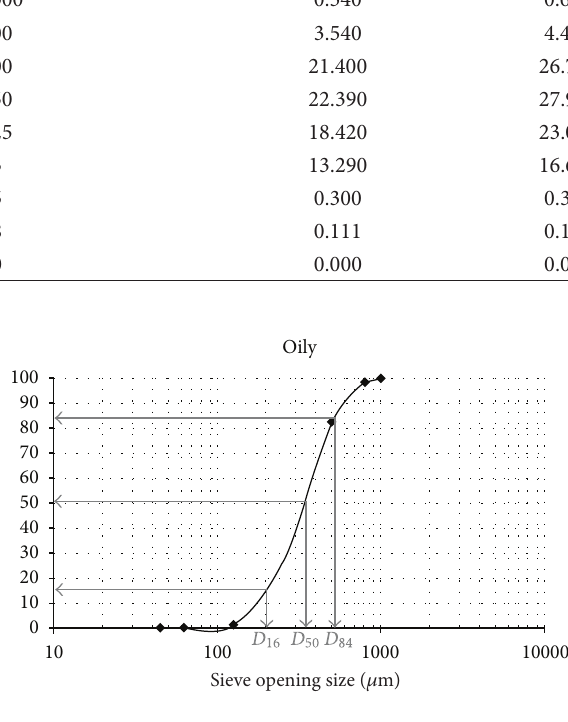
F 1: Lognormal distribution plot of cumulative undersize percentage of oily POME particles.